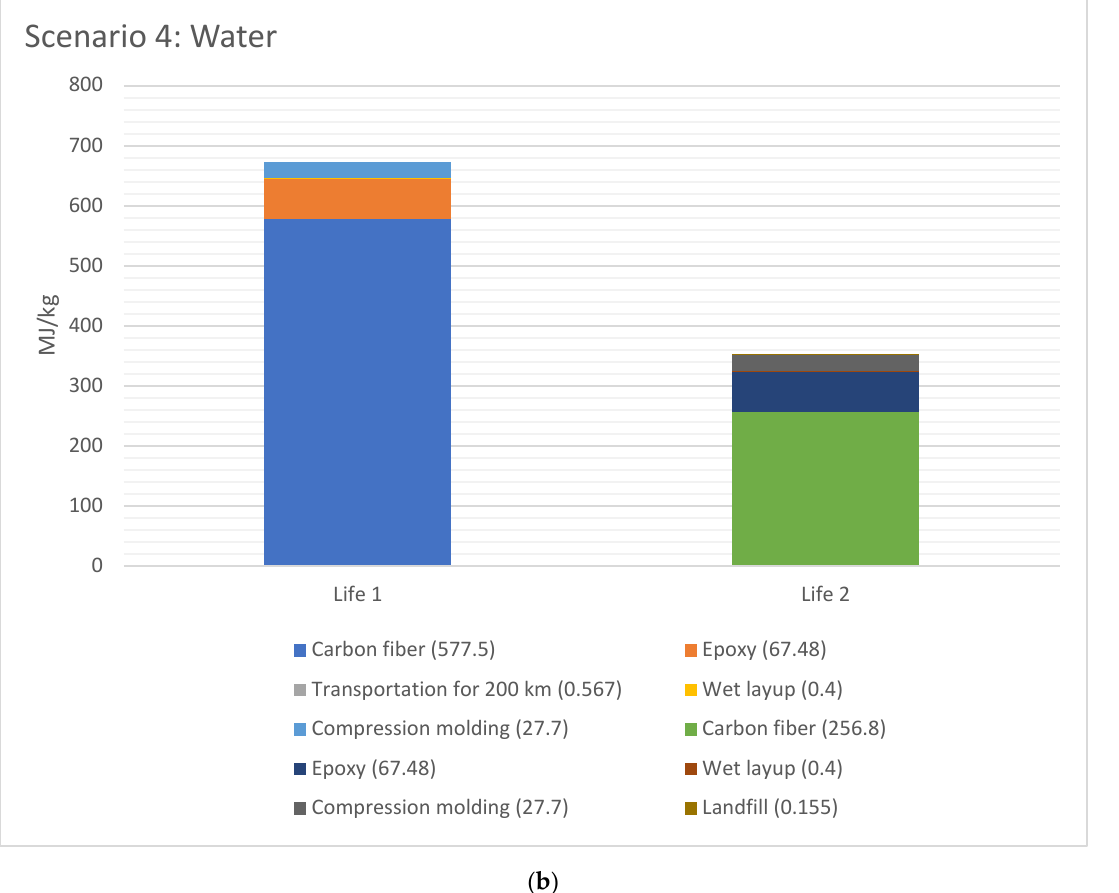
Figure 6. ( a ) EE difference between Life 1 and 2 for scenario 2 (acetone + water for 1 kg CFRP); ( b ). EE difference between Life 1 and 2 for scenario 4 (water for 1 kg CFRP).